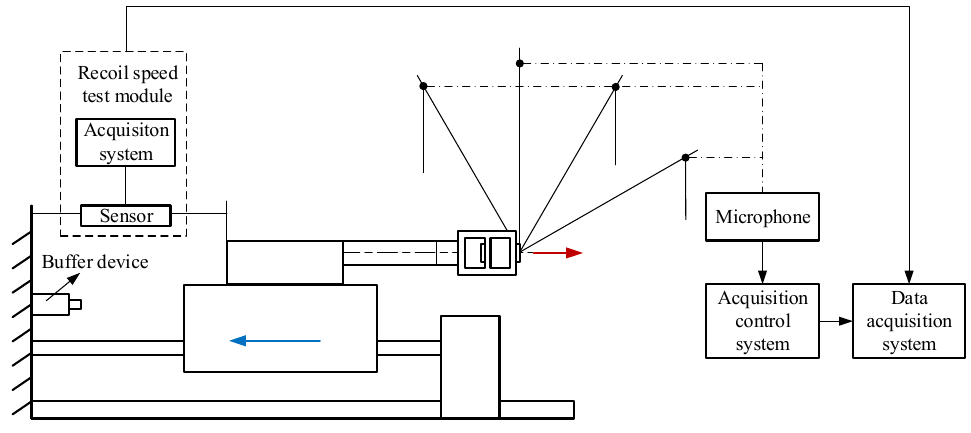
Figure 13. Schematic diagram of experimental